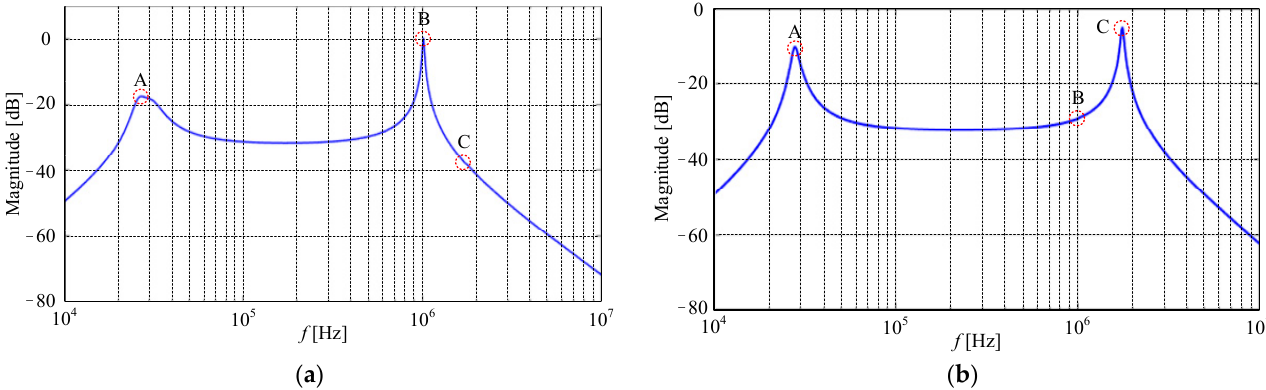
Figure 10. Bode plot of crosstalk interference between forward and backward information transfer. ( a ) Crosstalk from “Backward TX” to “Forward RX”. ( b ) Crosstalk from “Forward TX” to “Backward RX”.